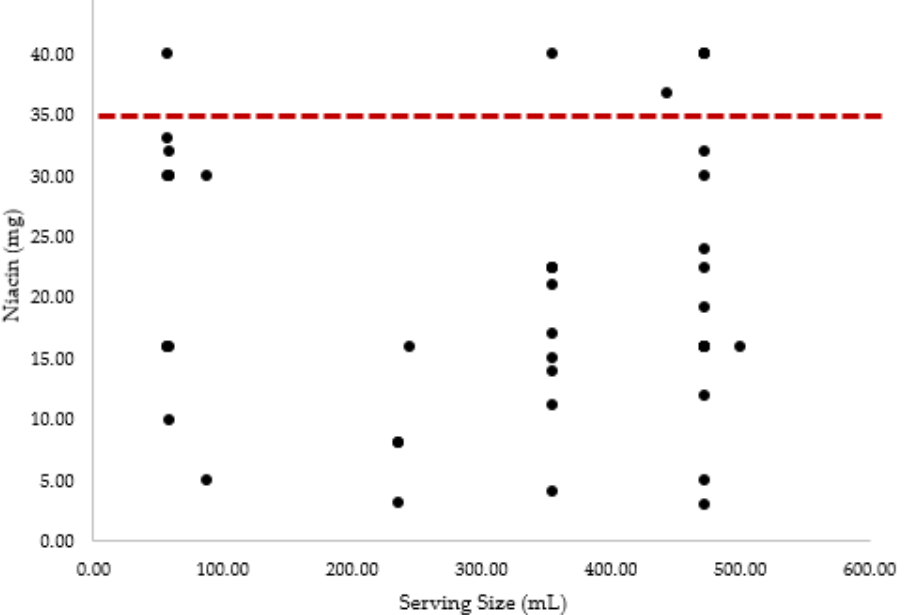
Table 2. Product class-specific prevalence and quantities of ingredients included in the bestselling energy drinks and energy shots per serving size.